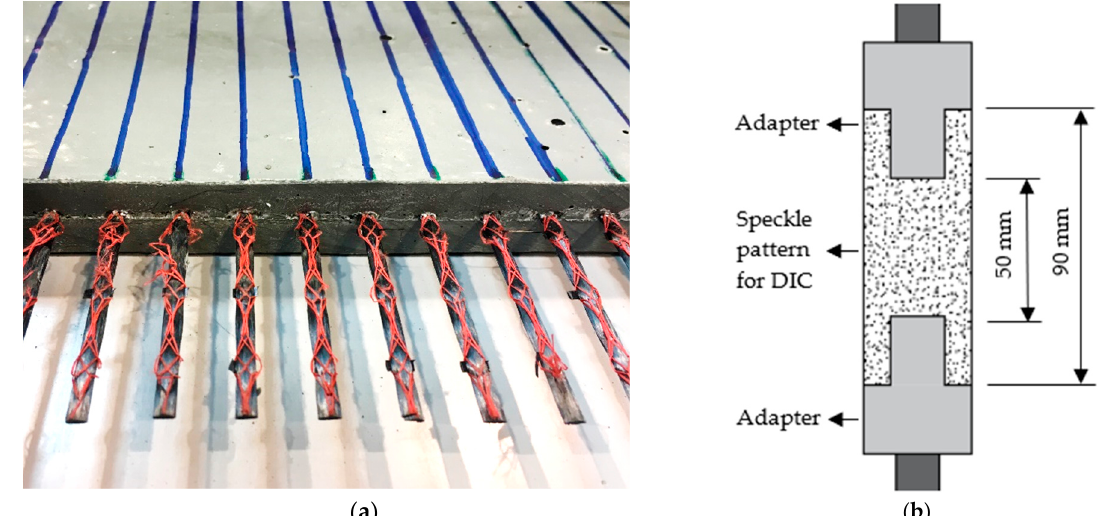
Figure3. Specimenproductionfortensiontests: ( a )plateafterdemolding; ( b )finalspecimendimensions Figure 3. Specimen production for tension tests: ( a ) plate after demolding; ( b ) final specimen and dimensions and fixities.